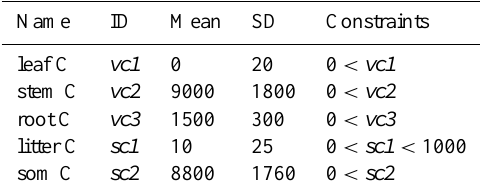
Table 2. Prior setup for the initial carbon pool amounts employed in D TR .